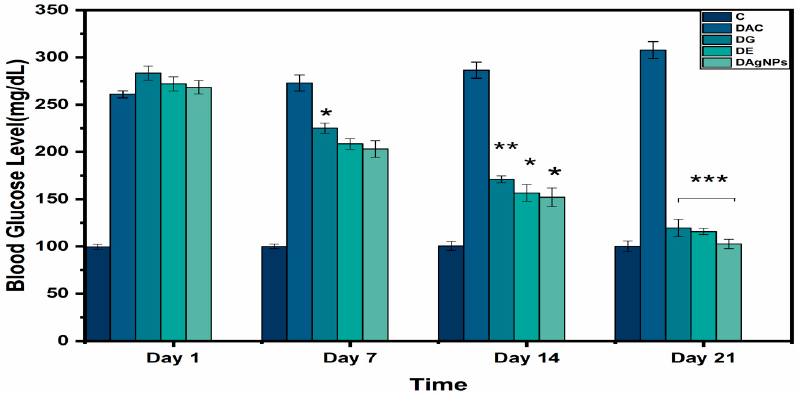
Figure 6. Blood glucose analysis of various treated groups; * p < 0.05; ** p < 0.01; *** p < 0.001 reveals statistically difference between groups. A glucose tolerance test was used to evaluate the improvement in hyperglycemic conditions among groups of rats treated with 10 mg/kg AgNPs. Glucose was administered orally to the animals. Glibenclamide (0.5 mg/kg body weight) was utilized as a reference